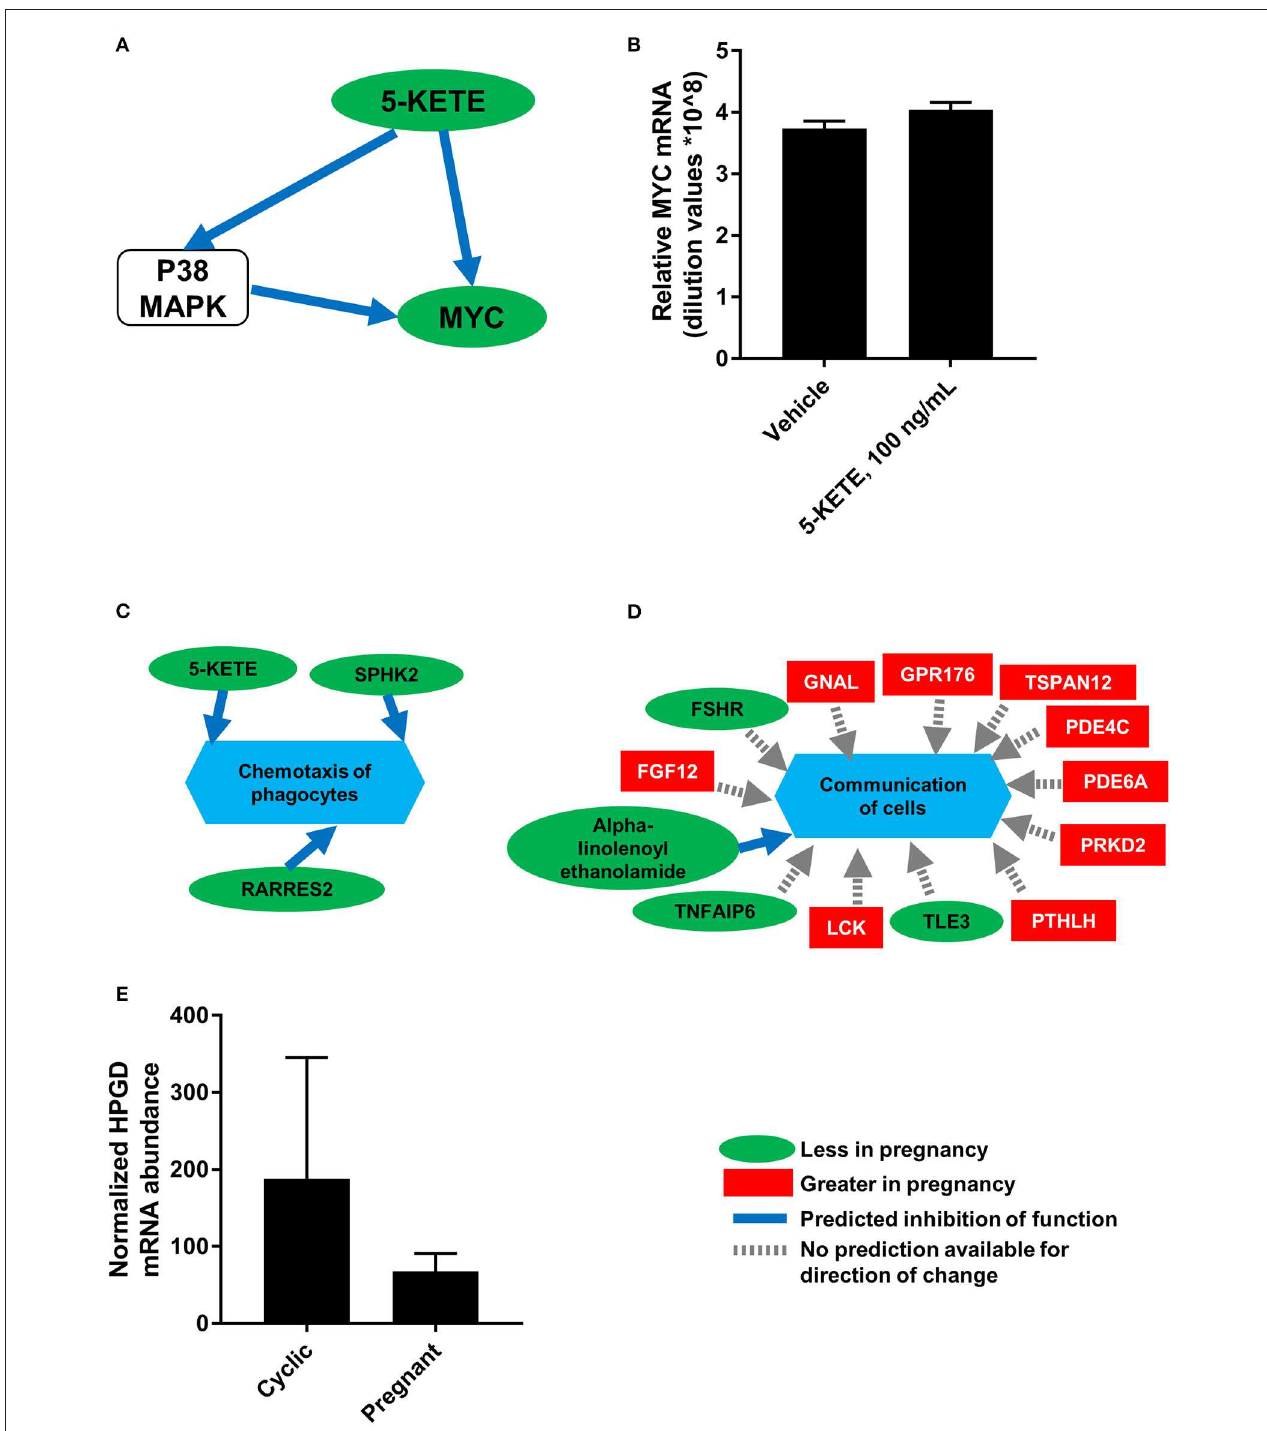
FIGURE 7 | Integration of luteal transcriptomics and metabolomics during maternal recognition of pregnancy [ N = 4/group for metabolomics and transcriptomics; (19)]. (A) The network from IPA indicating a relationship between 5-KETE and MYC, with a green oval indicating less abundance in the CL of pregnancy, a blue arrow indicating predicted inhibition, and a white rounded square indicating a molecule that was not measured. (B) Effect of 5-KETE on MYC mRNA abundance in cultured luteal cells ( N = 3). (C,D) Predicted functions of differentially abundant lipids and mRNA from maternal recognition of pregnancy, with a green oval indicating less abundance in the CL of pregnancy, a red square indicating greater abundance in the CL of pregnancy, a blue arrow indicating predicted inhibition, and a gray dashed arrow indicating that no prediction is available for direction of change. (E) HPGD abundance on day 17 of the estrous cycle and pregnancy, as measured by transcriptomics; P =